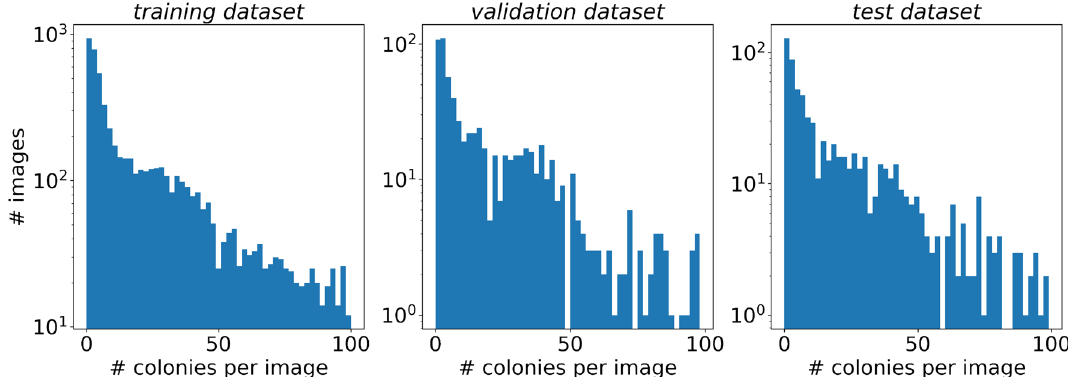
Figure 3. Histogram of the number of annotated microbial colonies per image in the training (left), validation (center), and test (right)